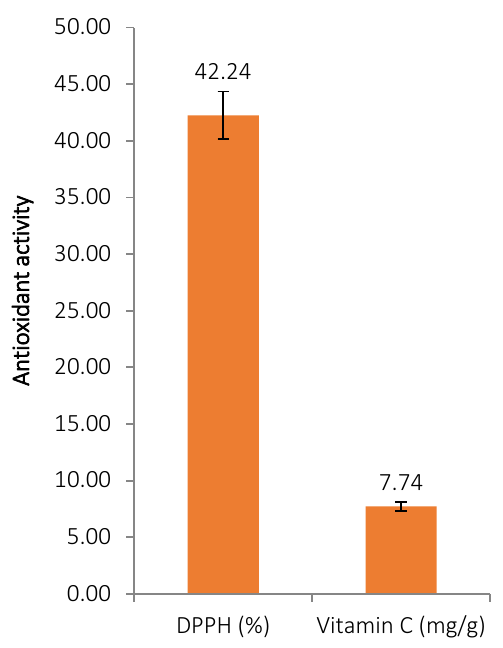
Figure 5. Antioxidant activity of A. occidentale leaf; DPPH: 2,2-diphenyl-1- picrylhydrazyl